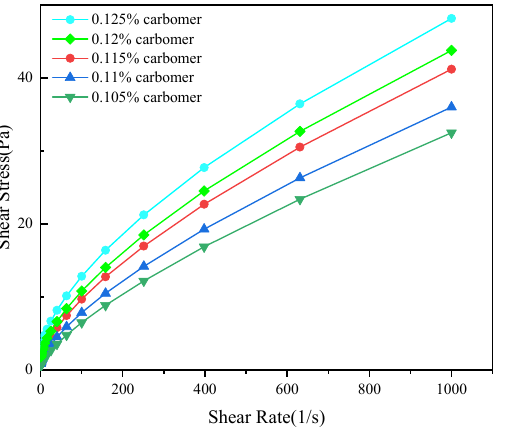
Figure 3. Rheological curves of carbomer aqueous solutions with different concentrations. The corresponding constitutive equations of Newton, Herschel-Bulkley and Power-law fluids (PLFs) are exhibited in Table